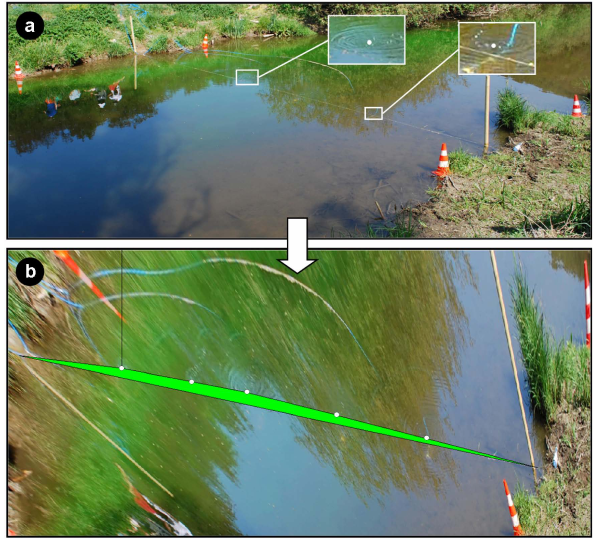
Fig. 9. Application in the river Sˆure; (a) shows two examples of marked bubbles, (b) shows the final result of the image processing from which the green area A can be obtained.